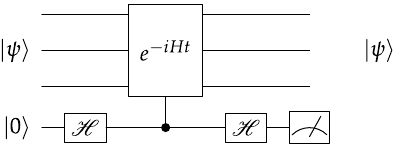
FIG. 3. One-qubit phase-estimation circuit. The symbol H denotes the Hadamard